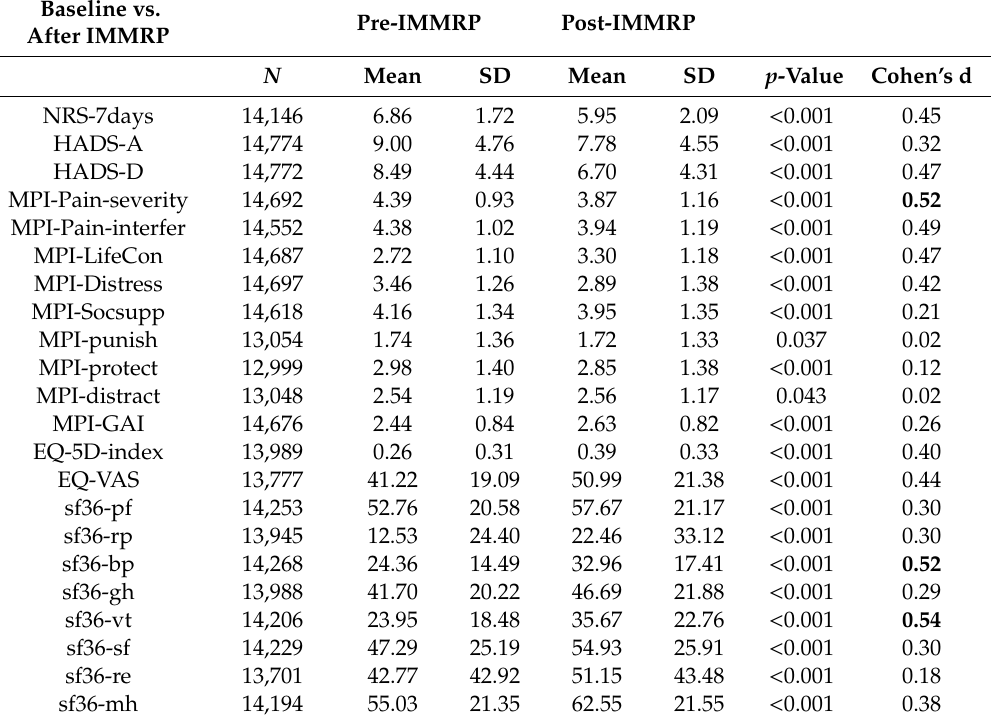
Table 2. Outcome variables at baseline (pre-IMMRP) and immediately after IMMRP (post-IMMRP). Statistical comparisons are presented furthest to the right together with e ff ects sizes (i.e., Cohen’s d). E ff ect sizes in bold were moderate, i.e., Cohen’s d ≥ 0.50. IMMRP: interdisciplinary multimodal pain rehabilitation